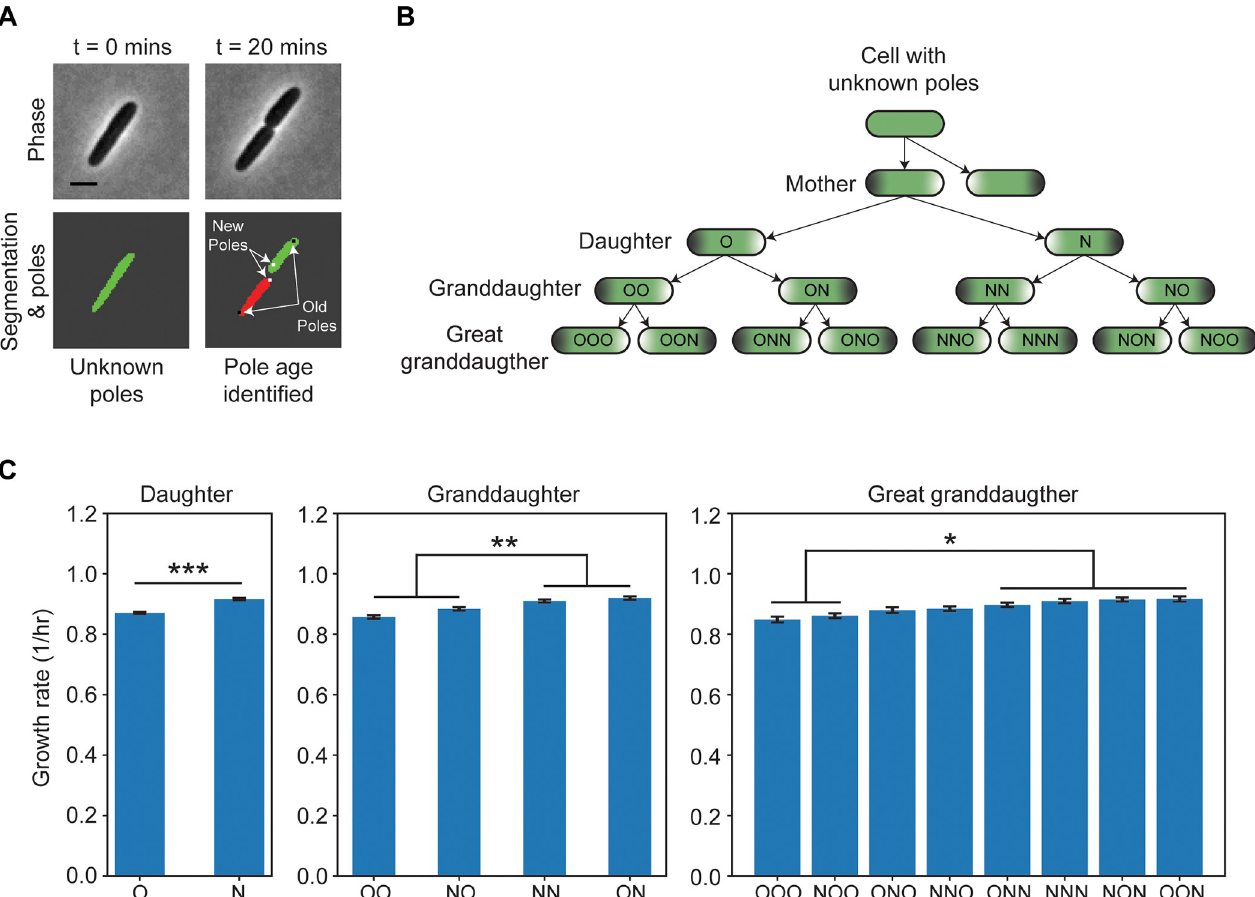
Fig 3. Pole age and its impact on growth rate. (A) Schematic showing how poles are passed down during a division. When a cell divides, the newly formed poles are defined as the ‘new’ poles (white dot) whereas the poles that were passed down from the mother are defined as the ‘old’ poles (black dot). Scale bar, 2 μ m. (B) Pole assignment schematic. When the mother cell with known poles divides, the daughter cell that inherits the mother’s old pole is denoted ‘O’ whereas the daughter that inherits the mother’s new pole is ‘N.’ For each generation, either an O or an N is appended to the pole history. (C) Growth rate within each generation. The growth rate of an individual cell is calculated for the period right after the mother’s division until right before the cell divides again. To reduce noise, only cells present for at least three frames were included in the analysis. Daughters (n = 11,246 cells; two tailed unpaired t-test; p-value ��� � 0.001), granddaughters (n = 10,726 cells; a one-way ANOVA with post hoc Tukey test used for statistical analysis. Statistical significance: ‘OO’ and ‘NO’ versus ‘NN’ and ‘ON’; p-value �� � 0.01), and great granddaughters (n = 10,217 cells; a one-way ANOVA with post hoc Tukey test used for statistical analysis. Statistical significance: ‘OOO’ and ‘NOO’ versus ‘ONN’,’NNN’,’NON’, and ‘OON’; p-value � � 0.05). Error bars show standard error of the